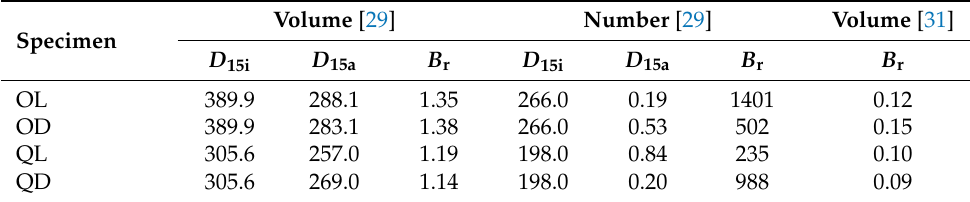
Table 2. Breakage values computed using volume and number distribution using Lee and Farhoomand [29] equation and volume distribution using Einav [31] ultimate fractal distribu- tion